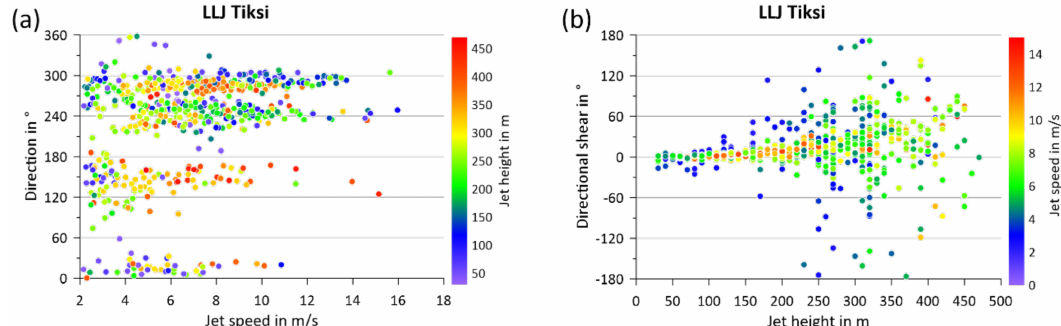
Figure 19. left ( a ): Scatter plot of the jet direction against jet speed with jet height color coded. Right ( b ): Scatter plot of the directional shear against jet height with jet speed color